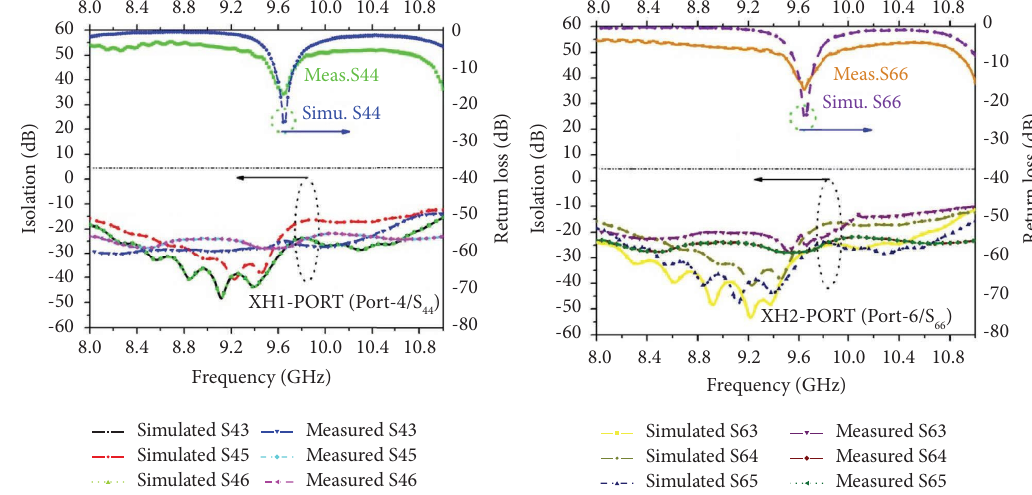
Figure 6: Frequency versus return loss and isolation of XH1 and XH2-ports.